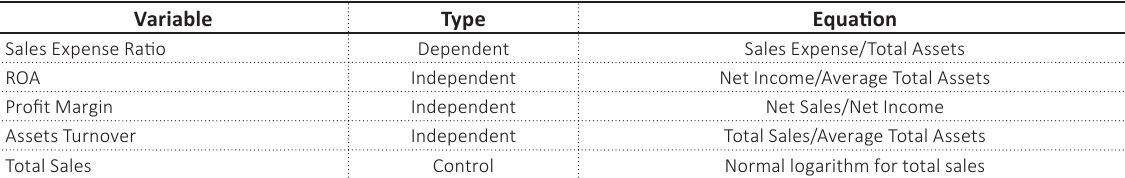
Table 1. Study variables